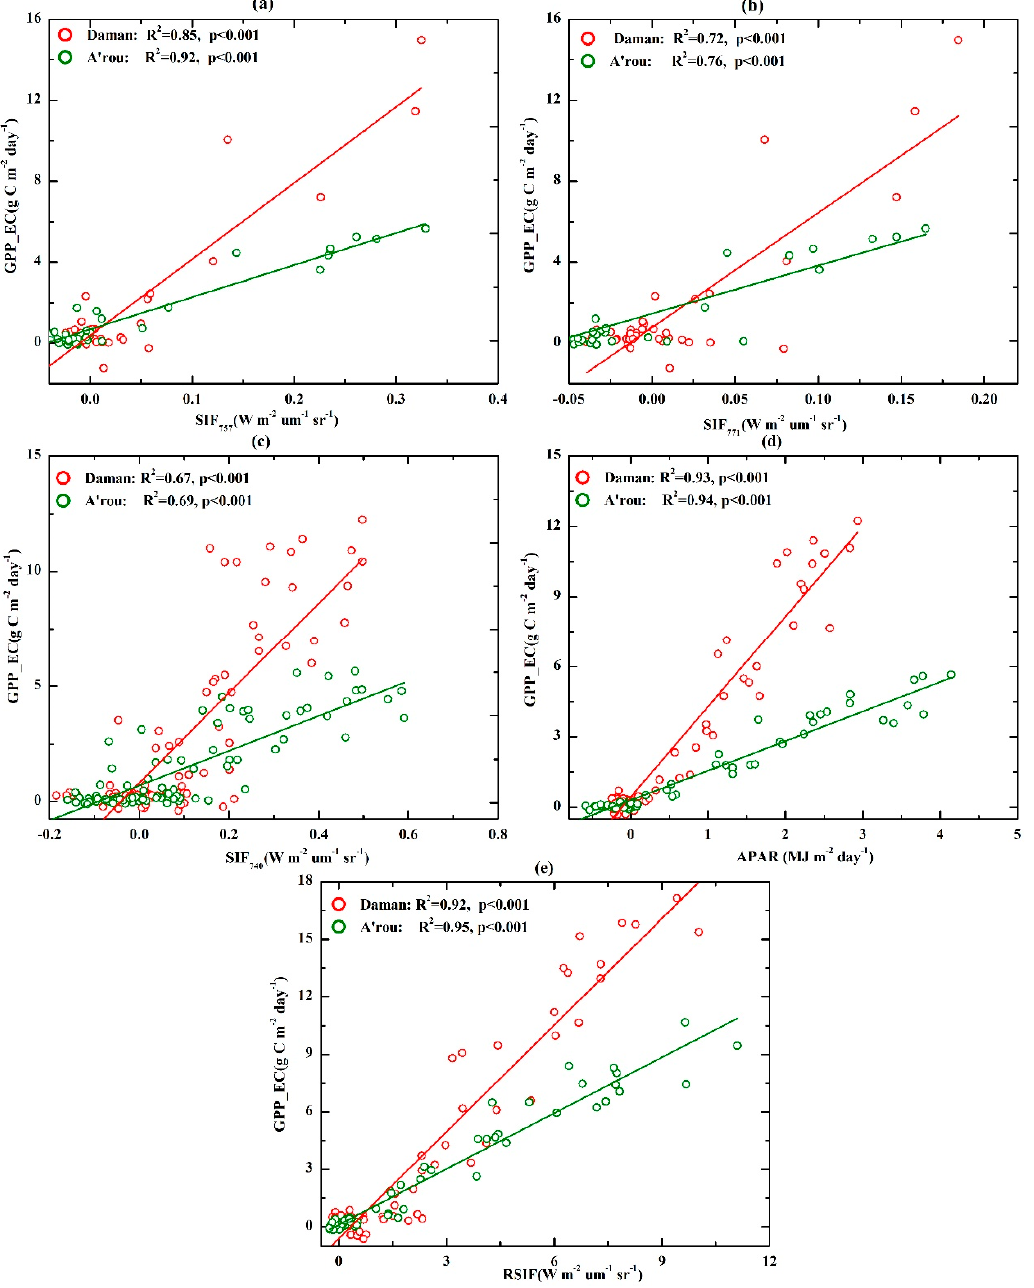
Figure 3. Scatterplot of the flux tower GPP and ( a ) SIF 757 and ( b ) SIF 771 at a daily timescale, as well as ( c ) SIF 740 , ( d ) APAR, and ( e ) RSIF at a 16-d averaged timescale for the period 2014–2017.